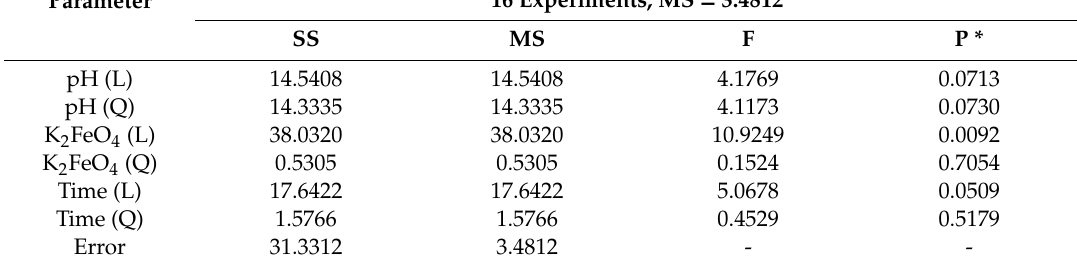
Table 8. Analysis of the CCD experiment using Statistica 13–verification of the adequacy of the model using ANOVA.